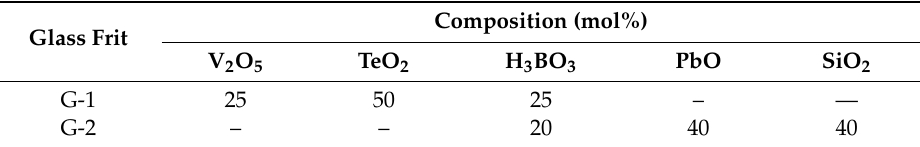
Table 1. Composition of the glass